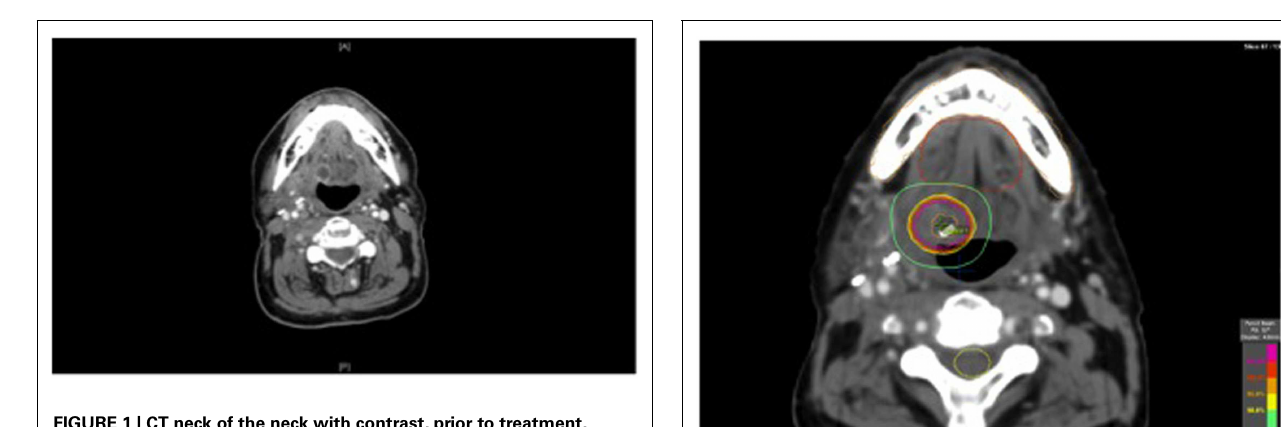
FIGURE 1 | CT neck of the neck with contrast, prior to treatment, demonstrates a submucosal irregularity that was ultimately biopsied and diagnosed as recurrent squamous cell carcinoma .